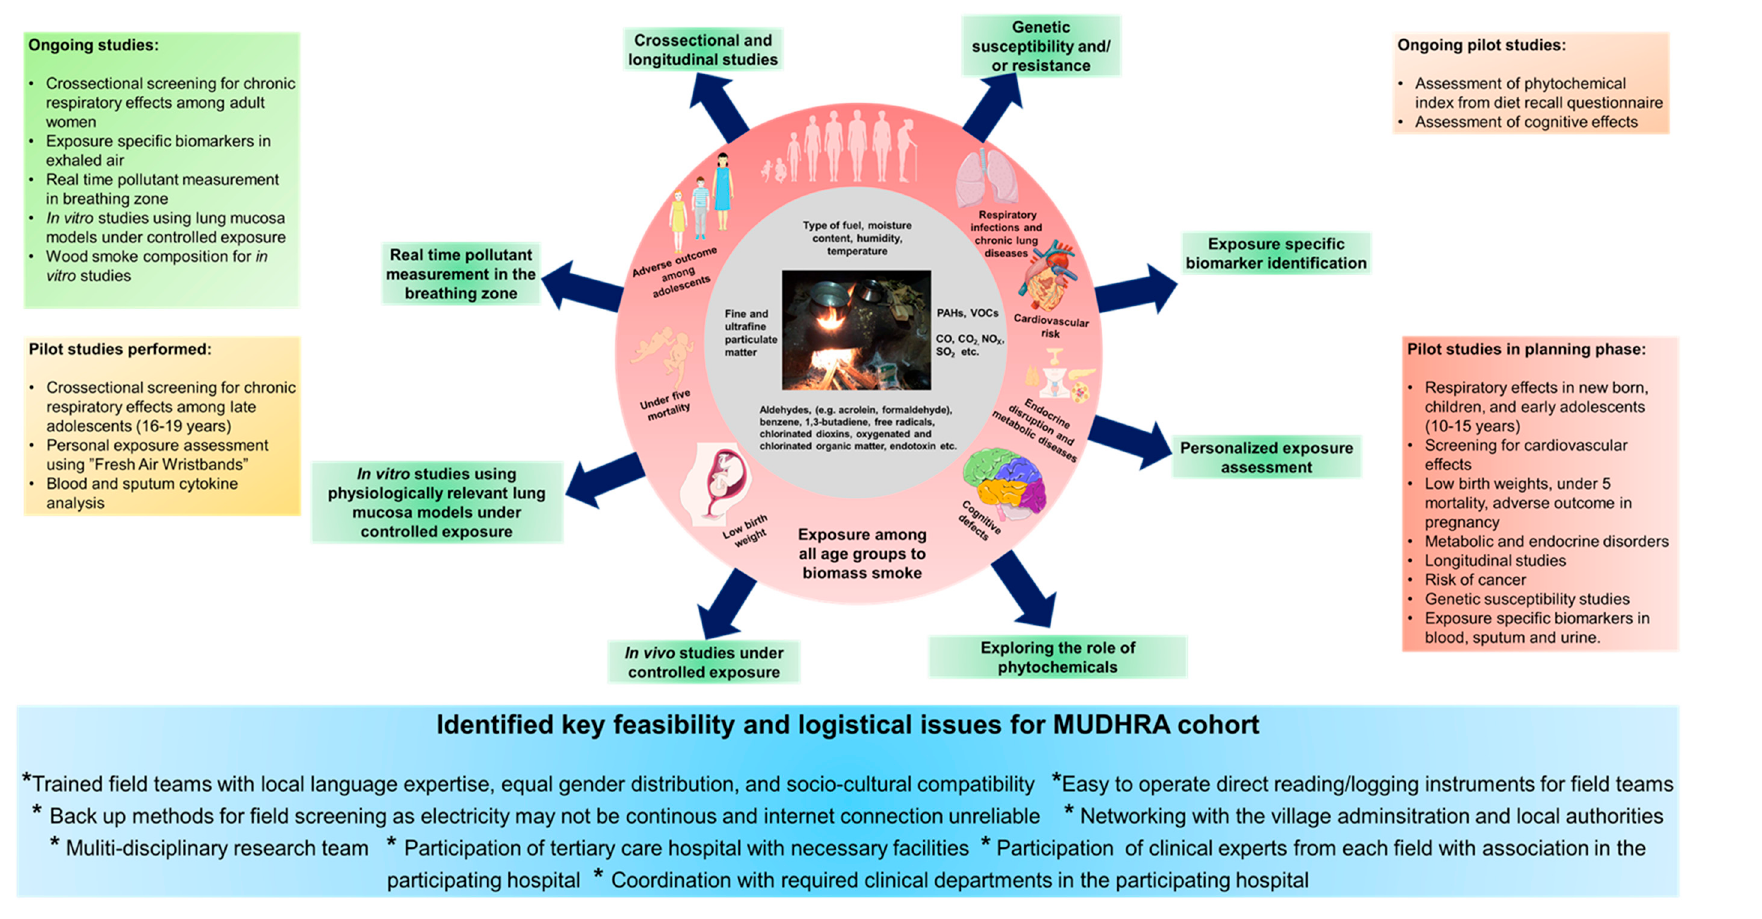
Figure 2. Summary of the main conclusions of the workshop.